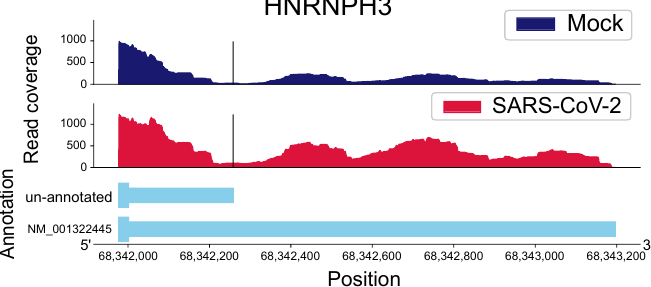
Figure 3. One example of a gene ( HNRNPH3 ) shows an alternative polyadenylation event in the 3 (cid:48) -UTR region. The black vertical line indicates the potential cleavage site. The x -axis and y -axis represent the position of the gene in its chromosome and the read coverage, respectively. The top two subplots show the changes in read coverage surrounding the event, and the cleavage site is indicated by a black vertical line. The bottom part of the plot shows both the full length and truncated 3 (cid:48)